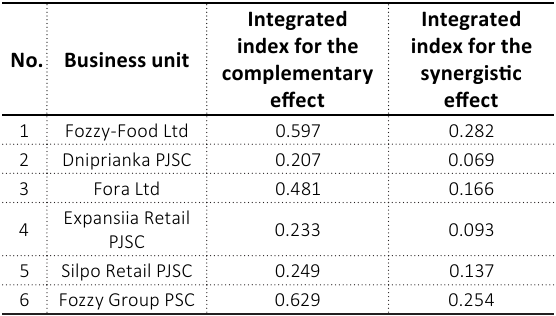
Integrated Integrated index for the index for the complementary synergistic effect effect